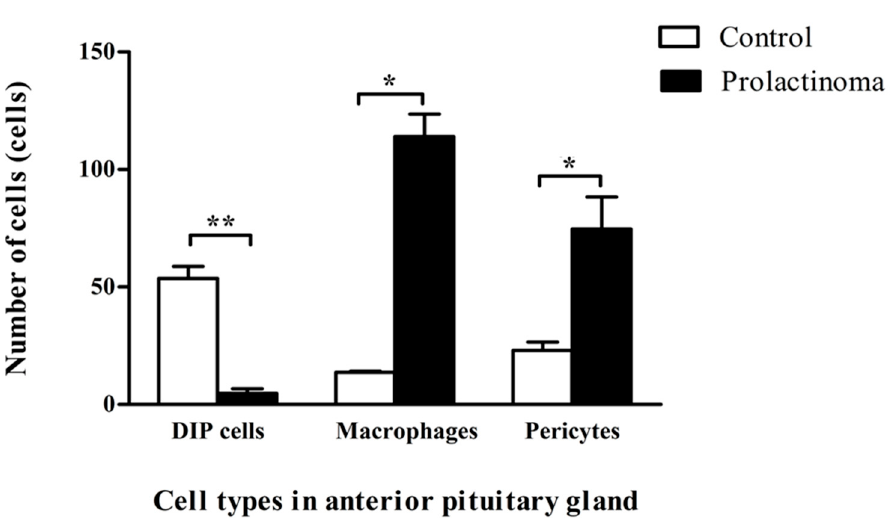
Figure 5. Number of cells in the perivascular space of anterior pituitary glands in control ( n = 3 rats) and prolactinoma rats ( n = 3 rats). Values are the mean ± SEM. Desmin-immunopositive perivascular (DIP) cells, ** p < 0.001; macrophages, * p < 0.005; and pericytes, * p < 0.005 .